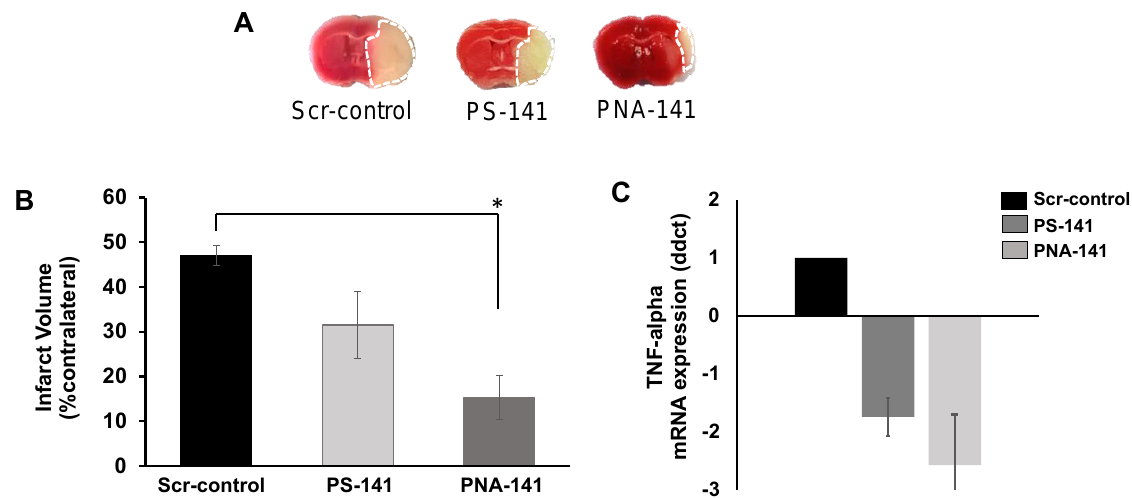
Figure 9. Anti-miR-141 treatment improves recovery in post-stroke socially isolated mice. ( A ) Representative coronal section of in vivo treated Scr-control (n = 7), PS-141 (n = 7), and PNA-141 (n = 8) treated brain section by TTC staining. ( B ) PNA-141 NP treatment significantly reduced infarct volume in post-stroke socially isolated mice compared to Scr-NP (* p < 0.05 vs. Scr-NP). PS-NP show moderate but insignificant reduction of infarct volume. ( C ) Relative gene expression of inflammatory marker TNF-alpha in the control group and NPs-treated group as indicated. Data are presented as mean ± standard error mean (SEM).